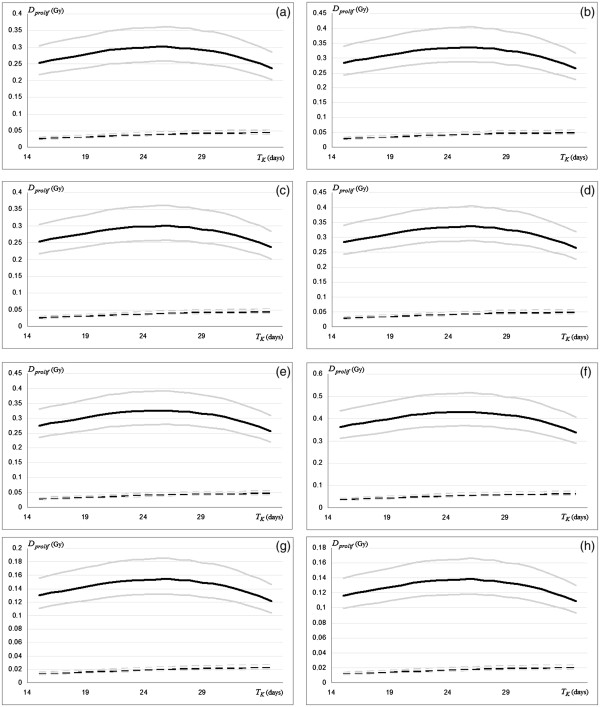
Curves of Dprolifobtained by varying Tk, for HEGFr(continuous) and LEGFr(dashed) groups based on the flow cytometry (left column) and immunohistochemistry (right column) methods to estimate the sub-sites iTpot. Sensitivity analysis is shown with respect to different values of α with α/β = 10 Gy: α = 0.25 Gy-1 (upper curves); α = 0.3 Gy-1 (mean curves); α = 0.35 Gy-1 (bottom curves). Differences are shown for Oral-Cavity (a,b), Oropharynx (c,d), Hypopharynx (e,f) and Larynx (g,h).